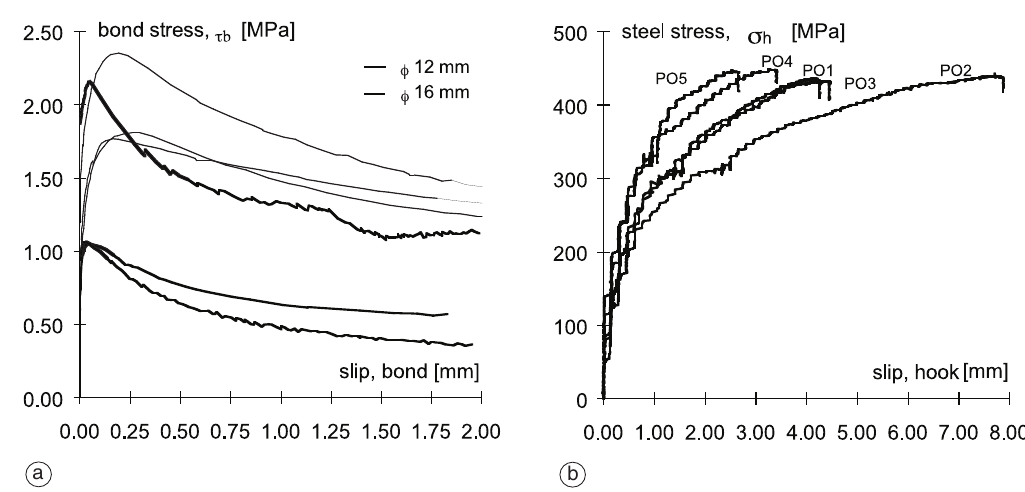
a b Fig. 8a,b. Test results: a) bond stress-slip in the straight rebars; b) bond stress-slip in the hooked rebars.